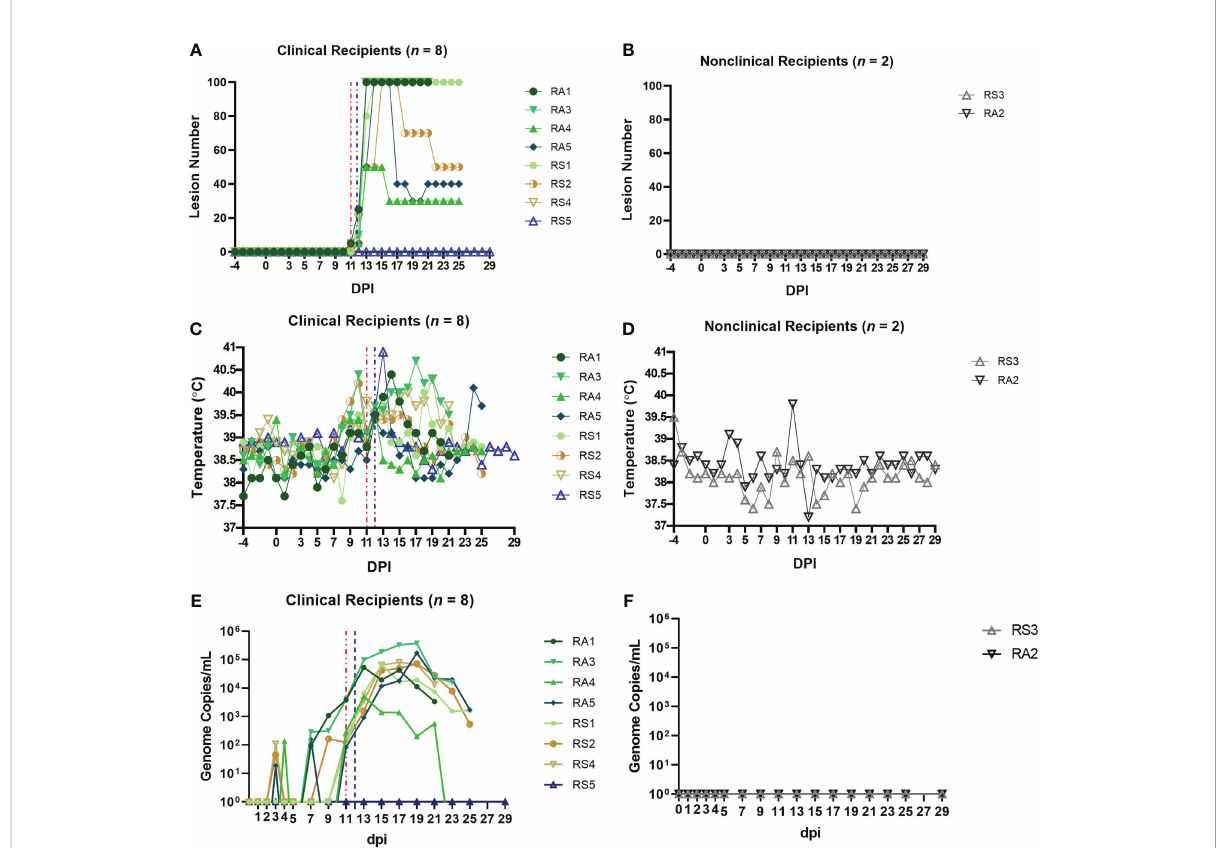
FIGURE 6 Eight out of ten arthropod – inoculated calves developed clinical signs consistent with LSD approximately 11 days after the start of inoculation. The number of cutaneous lesions in the clinical (A) and nonclinical (B) calves were recorded each day, up to a maximum of 100 lesions. The rectal temperature of clinical and nonclinical calves (C, D) was recorded daily. The number of LSDV genome copies in the blood of each calf was quanti fi ed by qPCR. (E, F) The red dotted line represents the onset of cutaneous lesions for group RS cattle and the blue dotted line the onset of cutaneous lesions for group RA